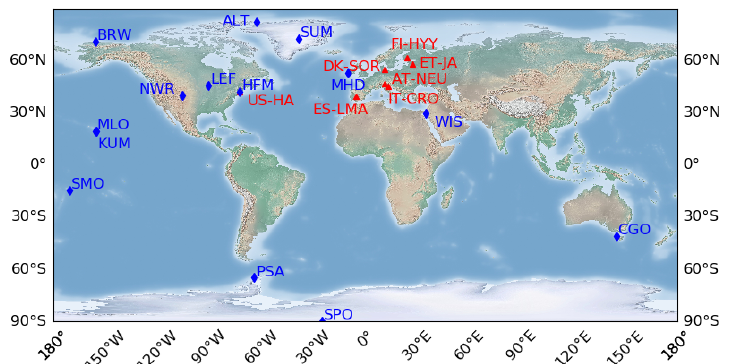
Figure B1. Locations of the observation sites for soil COS flux measurements (red) and atmospheric concentration measurements (blue).